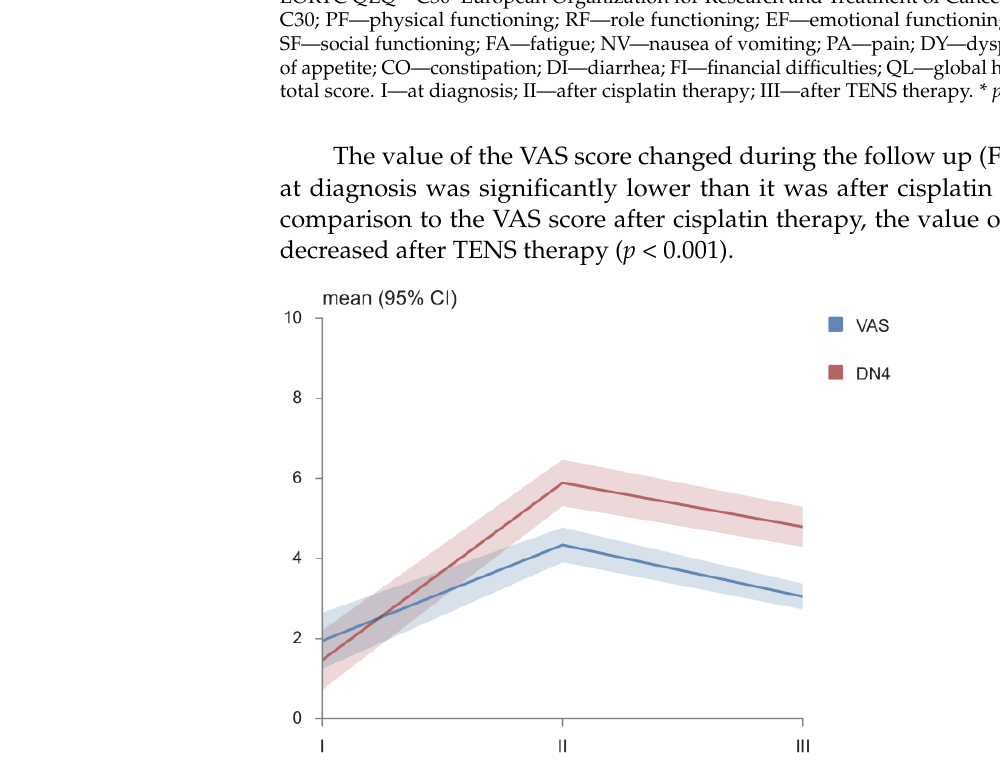
Figure 4. VAS and DN4. VAS — Visual Analogue Scale; DN4 — Douler Neuropathique in 4 ques- tions.